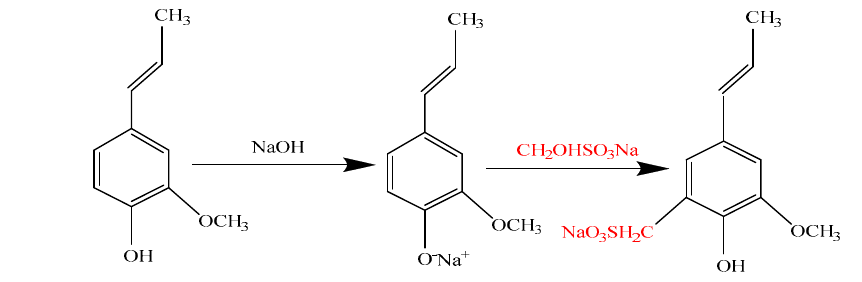
Scheme 1. The sulfomethylation scheme of lignin.